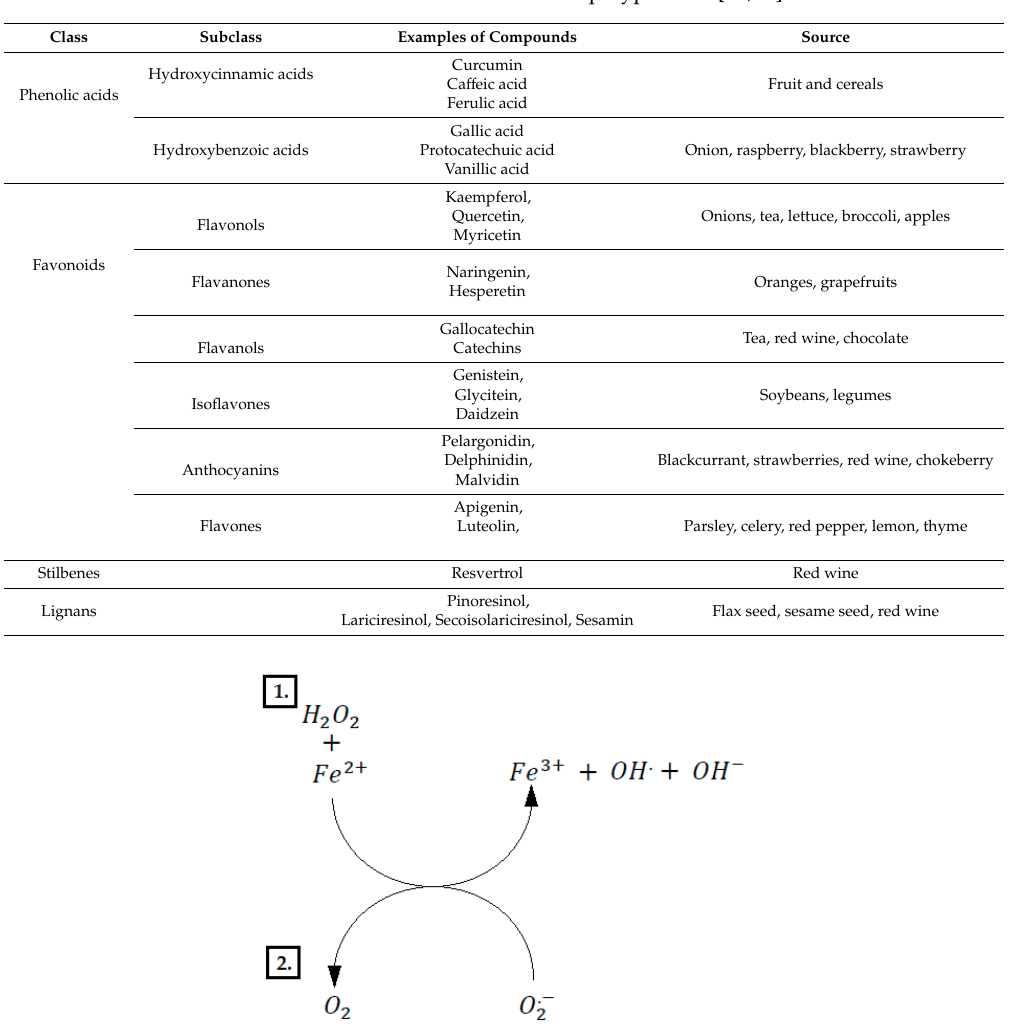
Figure 2. Fenton’s cycle. 1. H 2 O 2 is broken down into OH . and OH − in the presence of Fe 2 + 2. Reduction of Fe 3 + to Fe 2 + by superoxide anion radical. Table 1. The classification of natural polyphenols [36,37]